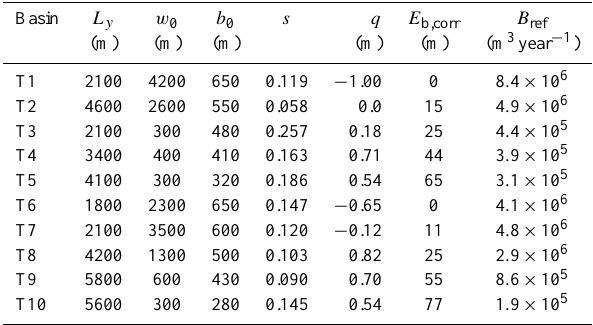
Table 1. Parameter values of the geometric characteristics of the basins that feed the main stream. See Fig. 1 for the location of the basins. The last column shows the mass input (ice volume) to the main glacier corresponding to the reference state described in the next